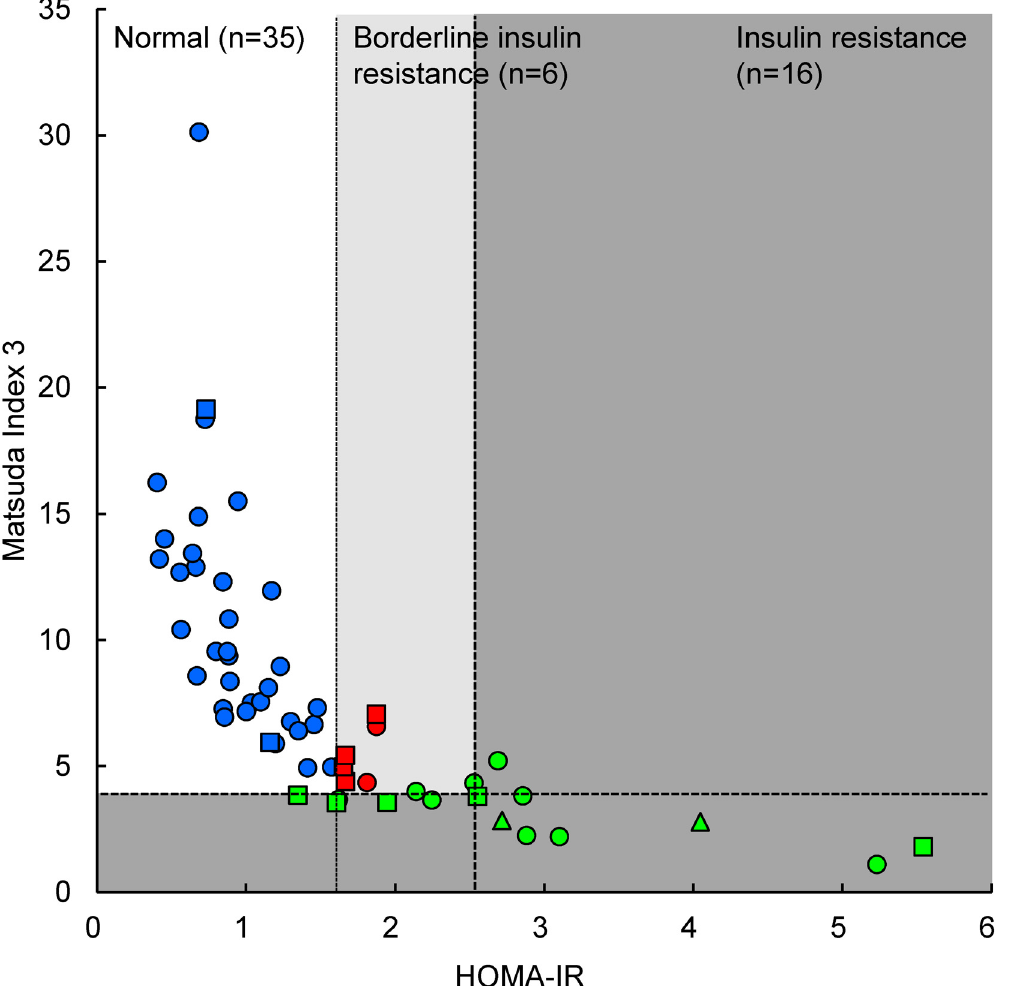
Fig 3. Classification of insulin resistance using the oral glucose tolerance test. Blue, normal insulin resistance; red, borderline insulin resistance; green, insulin resistance determined by homeostasis model assessment of insulin resistance and Matsuda Index 3. Circle, Group N (normal); square, Group HN +IGT ( “ high-normal ” and impaired glucose tolerance); triangle, Group D